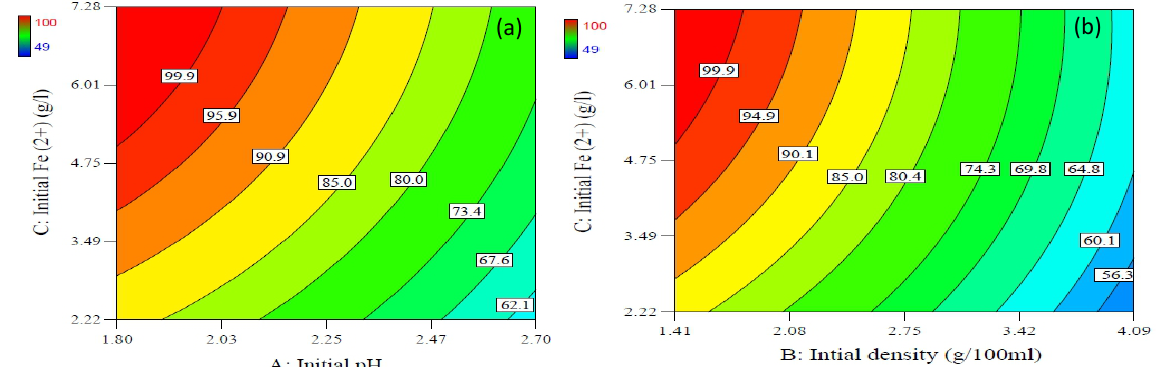
Fig. 4. Contour plots of the interaction effects for Cu recovery: (a) initial Fe 2+ vs. initial pH at a constant initial pulp concentration of 1.4 g/100 mL, (b) initial Fe 2+ concentration vs initial pulp density at a constant initial pH of 1.8